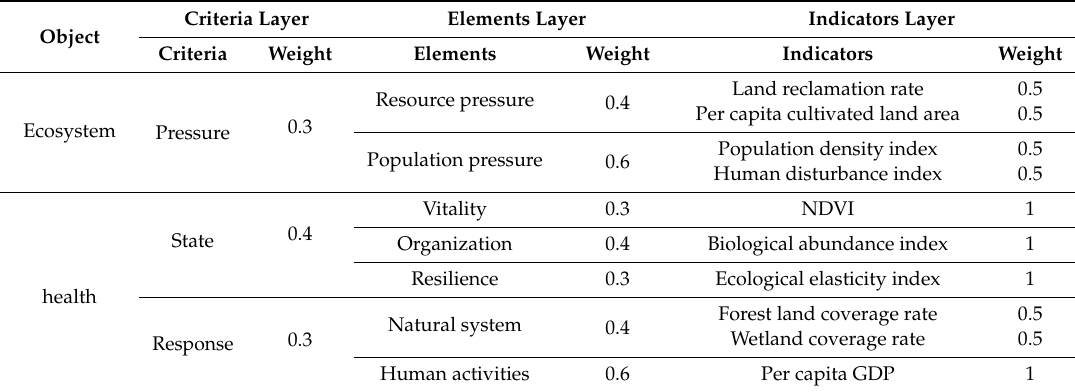
Table 3. Index system of ecosystem health